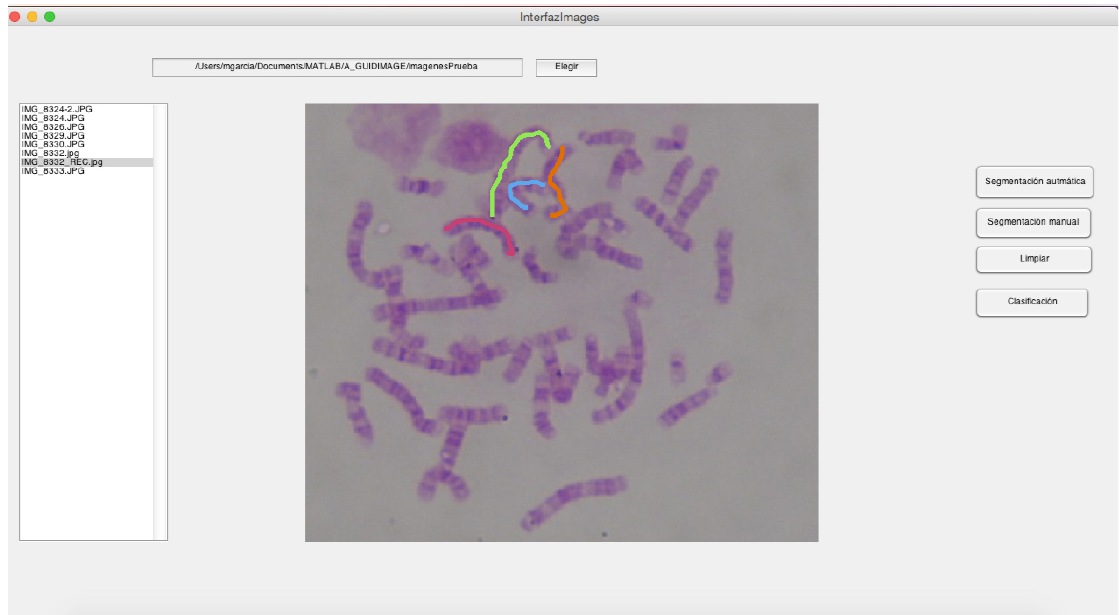
Figure 17. Screenshot of the proposed chromosome segmentation application used in manual chromosome segmentation mode.